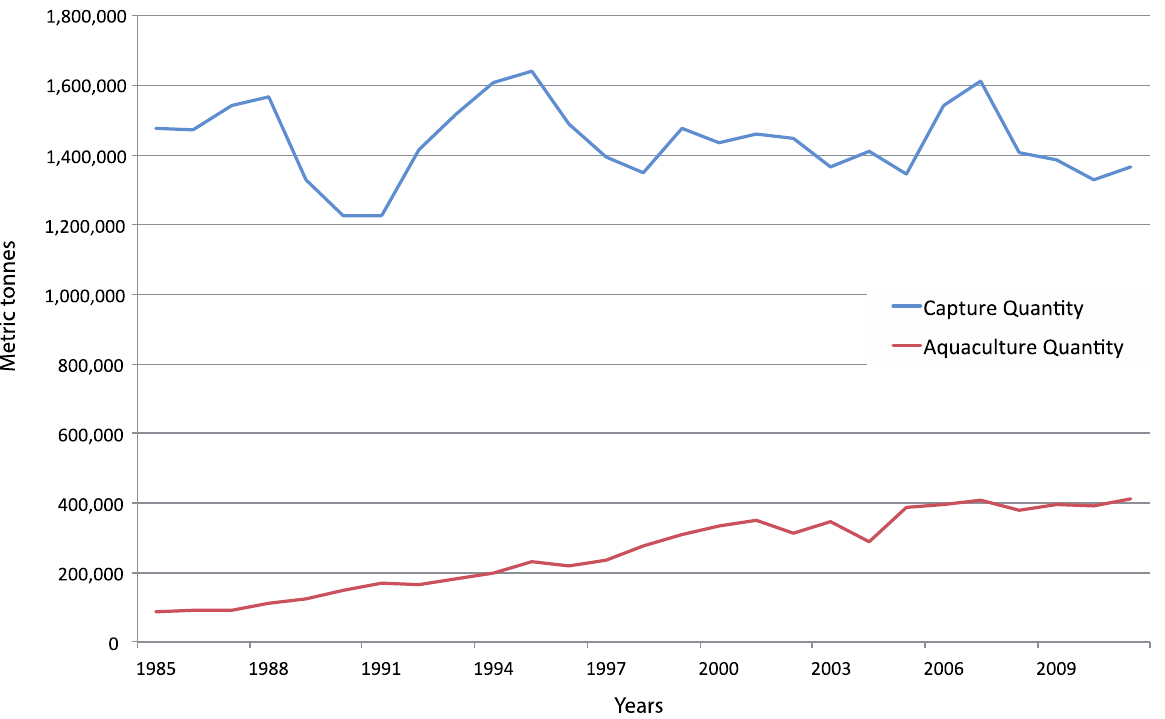
Figure 3. Capture and aquaculture production in the Mediterranean. (source: FAO